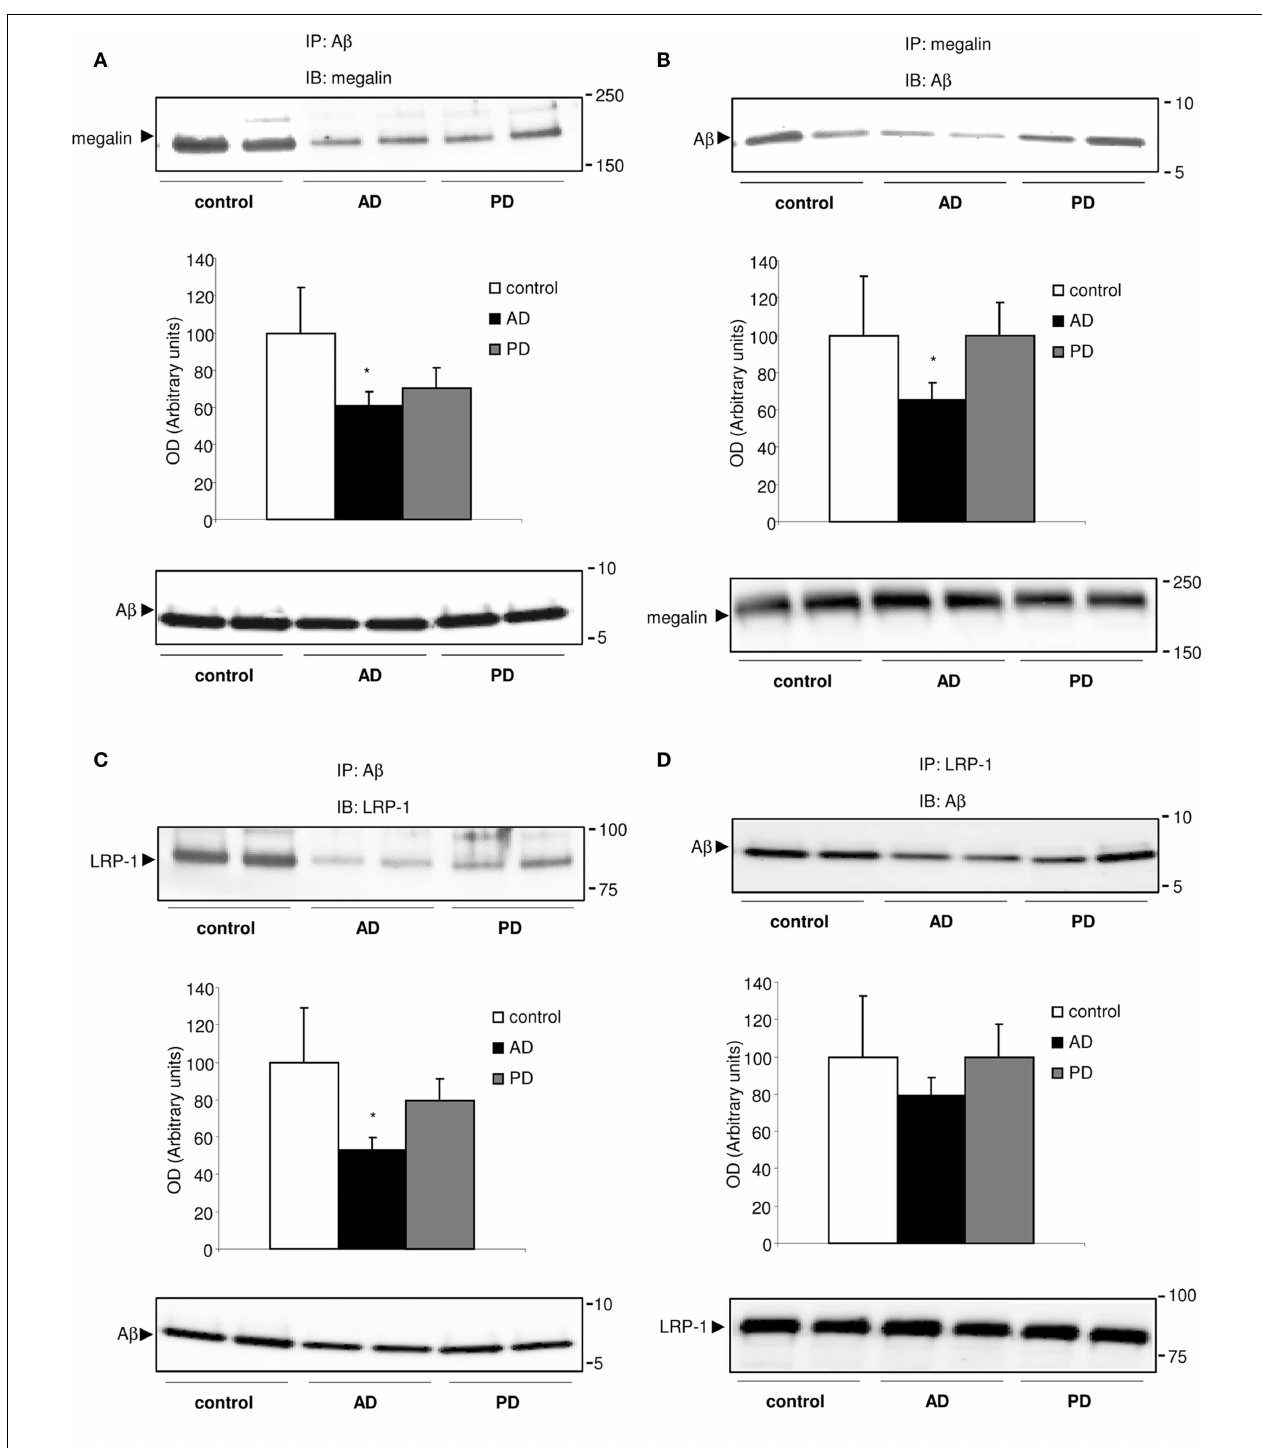
FIGURE 3 | Megalin-bound, and LRP-1-boundA β 40 in human CSF . (A–D) Co-immunoprecipitation of A β 40 with megalin and LRP-1 in human CSF. CSF samples were subjected to immunoprecipitation (IP) with an anti-A β antibody (A,C) , followed by detection of megalin, and LRP-1 onWestern blots (IB). Reversed immunoprecipitation with anti-megalin (B) and LRP-1